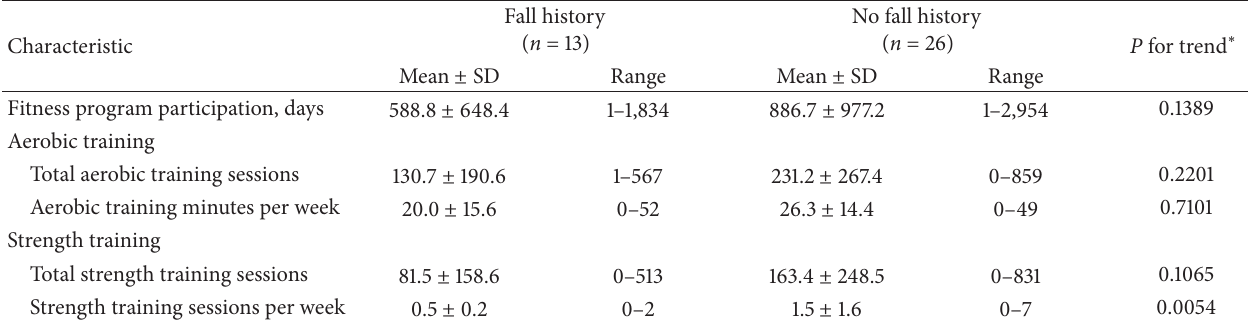
Table 1: Exercise participation in relation to fall status.